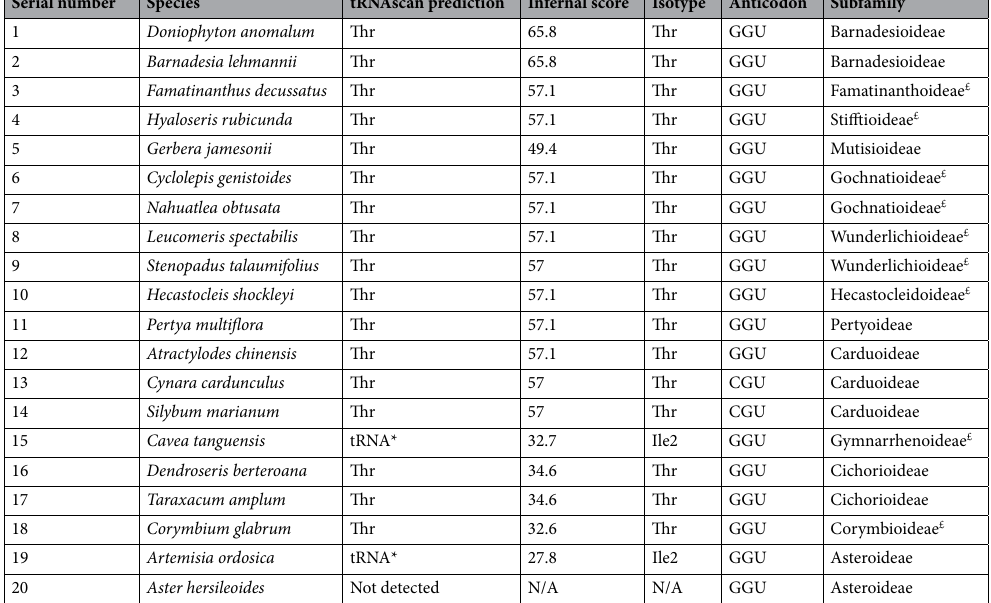
Table 1. Prediction of trn T-GGU genes in the representative species of 13 subfamilies. £ transfer RNA sequence extracted from raw read of Sequence Read Archive (SRA) of NCBI. * tRNAs with mismatch